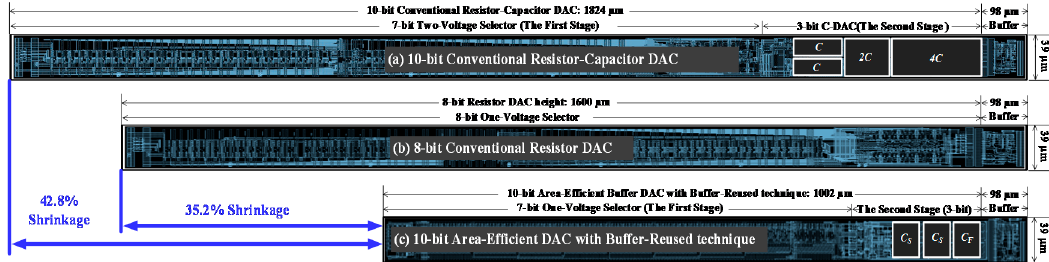
Figure 7. Comparisons of the layout dimensions for ( a ) the proposed buffer-reused 10-bit DAC, ( b ) the conventional 10-bit R-C DAC, as well as ( c ) the widely used 8-bit R-DAC. In order to verify the functionality, the proposed buffer-reused 10-bit DAC was firstly simulated.